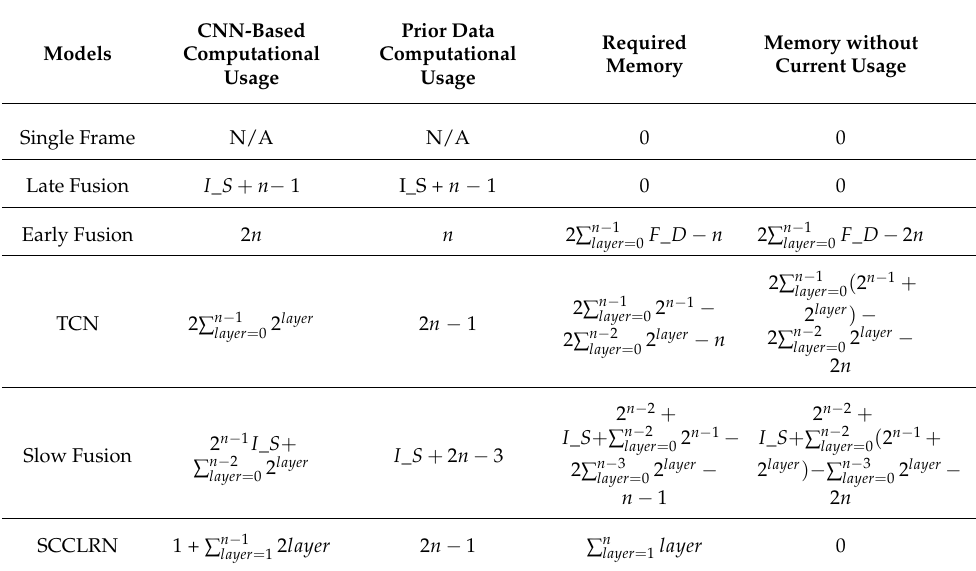
Table 1. Simple calculation formula for the amount of computation and memory consumption required by CNN-based sequence